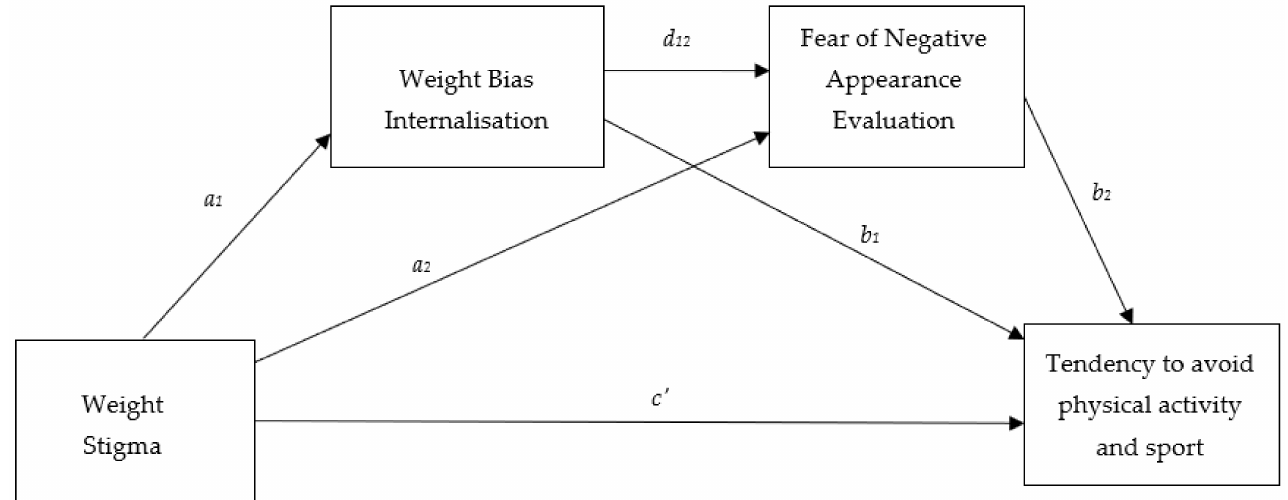
Figure 2. Conceptual Mediation Model. Indirect effect of weight stigma on tendency to avoid physical activity and sport through weight bias internalization only = a 1 , b 1 ; indirect effect of weight stigma on tendency to avoid physical activity and sport through weight bias internalization and fear of negative appearance evaluation in serial = a 1 , d 12 , b 2 ; direct effect of weight stigma on tendency to avoid physical activity and sport = c 1